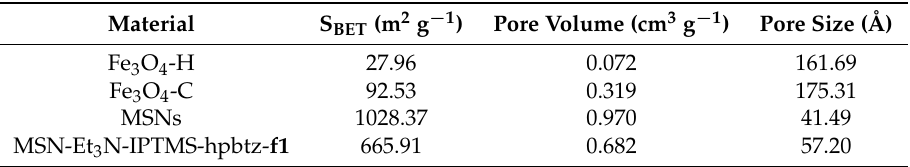
Table 1. Textural properties of magnetite nanoparticles (MNPs), mesoporous silica nanoparticles (MSNs), and MSN-Et 3 N-IPMS-hpbtz- f1 .